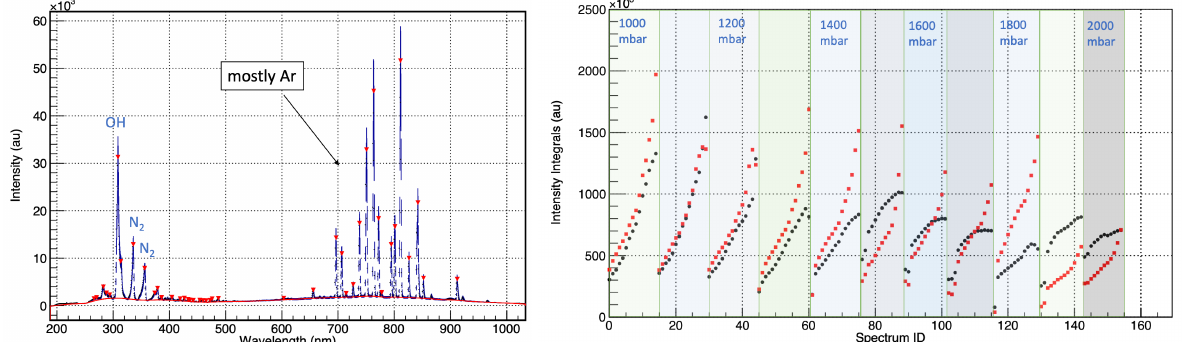
Figure 2. A sample average spectrum which shows the argon and impurity peaks in the 200–1000 nm range ( left ) and the intensity integrals due to argon emissions (red squares) and impurity emissions (black circles) during the high-voltage and pressure scan ( right